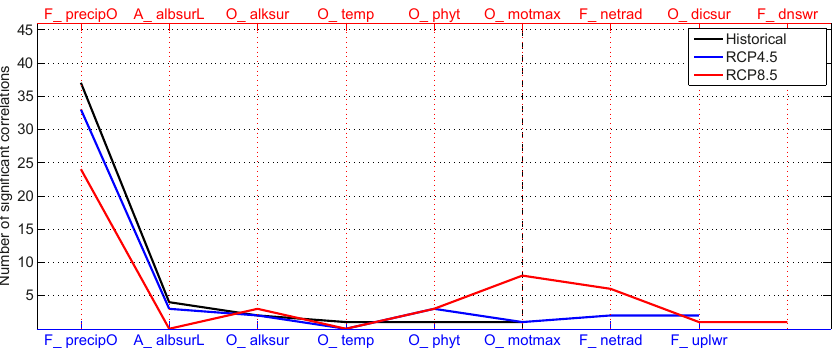
Figure 4. Indicators identified from the analysis of the RCP4.5 (blue) and RCP8.5 (red) correlation matrices with the precondition to use the historical indicators first. The indicators are as follows: “precipitation over ocean” (F_precipO), “land surface albedo” (A_albsurL), “ocean surface alkalinity” (O_alksur), “mean ocean temperature” (O_temp), “ocean phytoplankton” (O_phyt), “ocean overturning” (O_motmax), “net radiation at the top of the atmosphere” (F_netrad), “ocean surface dissolved inorganic carbon” (O_dicsur), and “downward shortwave radiation”